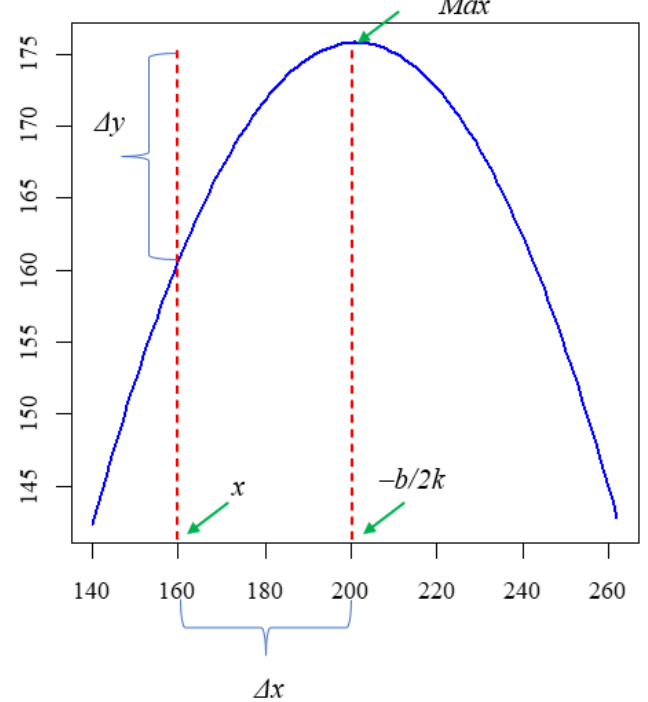
Figure A1. Model of the quadratic dependence of environmental indicators on time kx 2 + bx + c , where x is time. At time – b /2 k the function reaches maximum Max, which is a key characteristic of the dynamics of the indicator in that year. The different years may be compared in terms of this indicator. The time of space imaging x may be different from time – b /2 k in different years by ∆ x and a correction factor ∆ y must be found to find Max based on the information about the observed value of the indicator and the shift ∆ x